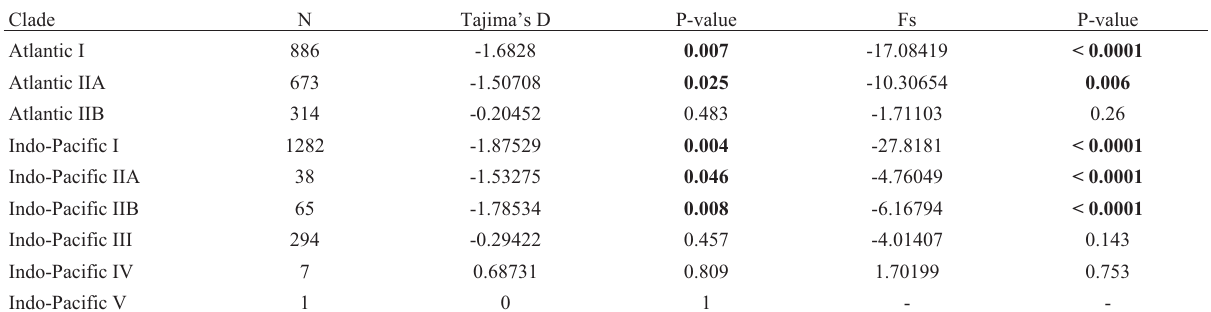
Table 2 - Neutrality tests in hawksbill turtles from worldwide rookeries and feeding areas, including Tajima’s D and Fu’s Fs tests based on mtDNA haplotypes (739 bp). N: sample size. Significant P-values are shown in bold. Clade N Tajima’s